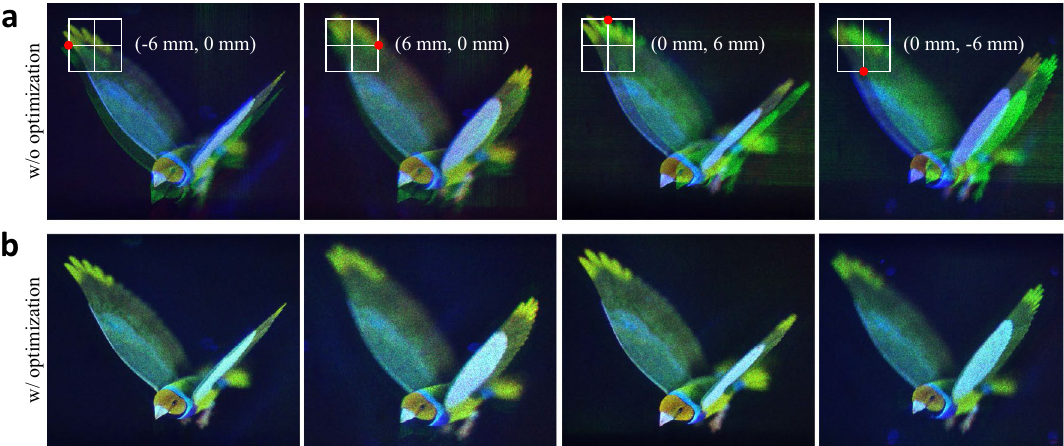
Figure 5. Viewpoint images observed at a position shifted by 6 mm to the left, right, top, and bottom with respect to the center position within the expanded exit-pupil. ( a ) A non-optimized CGH generates crosstalk, whereas ( b ) an optimized CGH reconstructs a target finch image without crosstalk. The finch image is purchased from TurboSquid, All Rights Reserved.